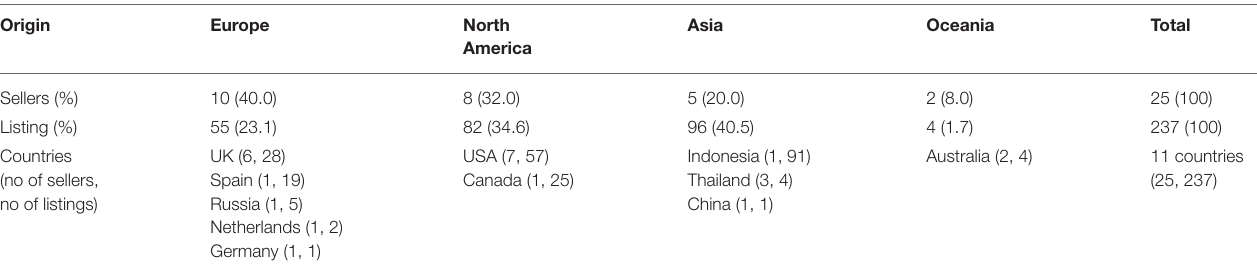
TABLE 2 | Geographical distribution of 24 sellers and 237 bat products retrieved from listings on eBay Australia, Canada, Italy, Switzerland, UK, USA between 11th and 25th of May 2020.